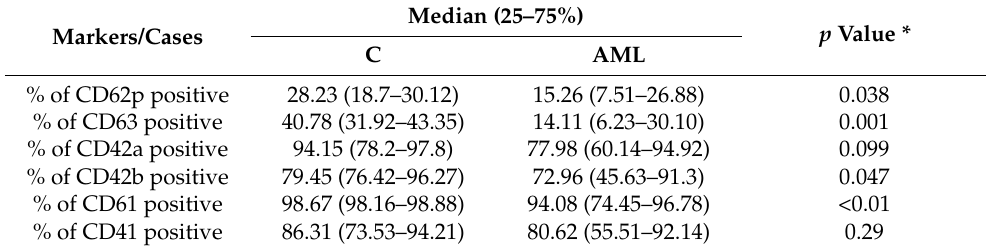
Table 2. Platelets’ antigens distribution in AML patients and controls.